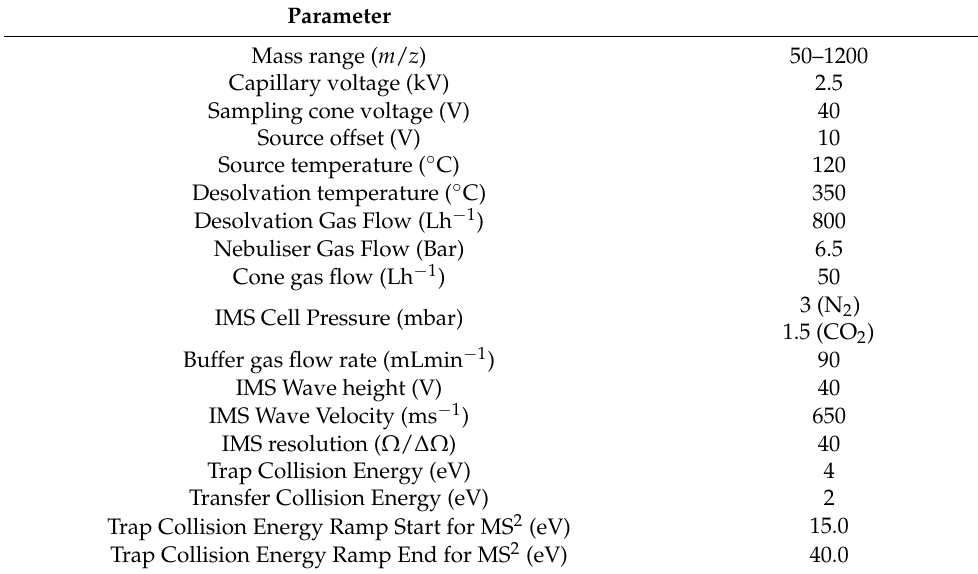
Table 1. Operating conditions for